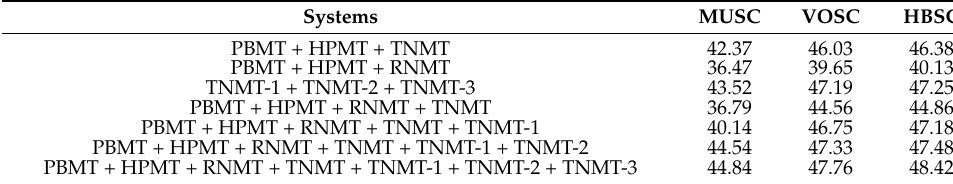
Table 9. Translation results (BLEU score) for the hybrid framework.